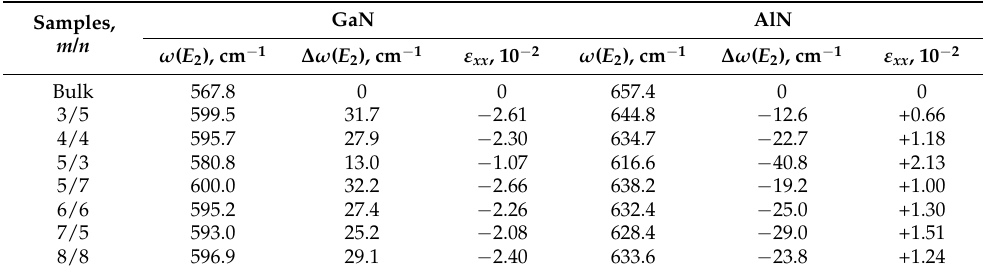
Table 5. Estimated values of in-plane strain ε xx in the (GaN) m / (AlN) n SLs. The negative sign of ε xx corresponds to the compressive